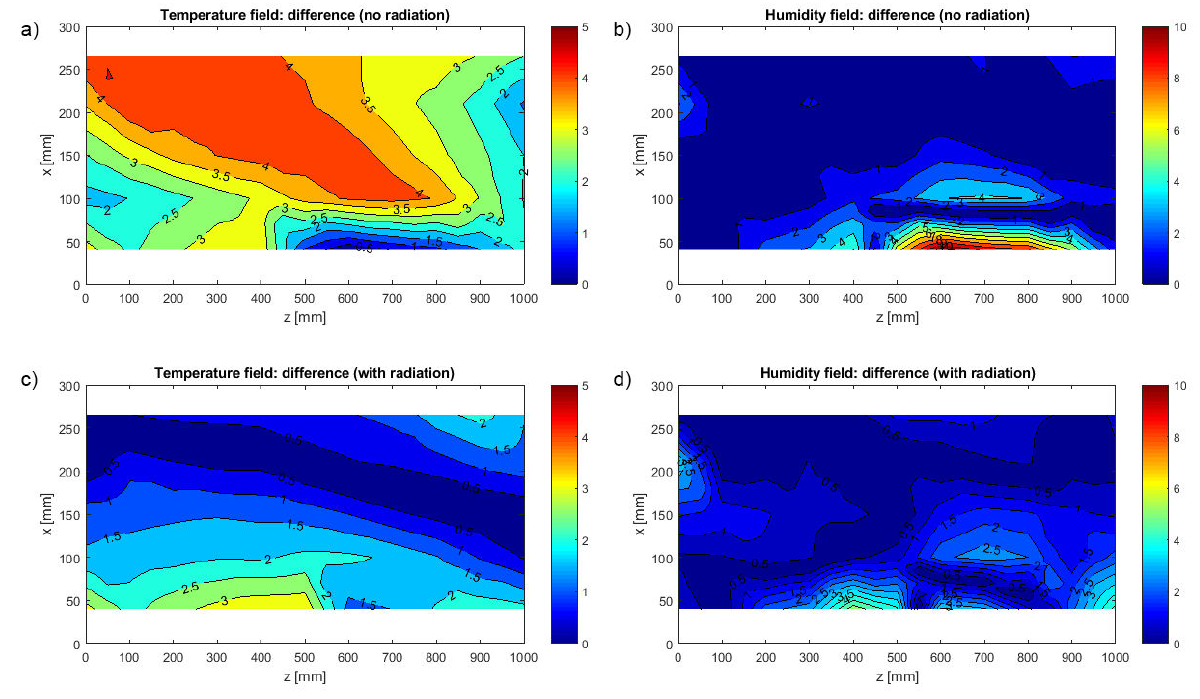
Fig. 6. Case 1 ( ∆ T = 30° C ): Comparison of experiment and CFD - measured field is subtracted from simulated field (absolute di ff erences are plotted), temperature di ff erences are in ° C (a,c); specific humidity di ff erences are in g v p / k g da (b,d)